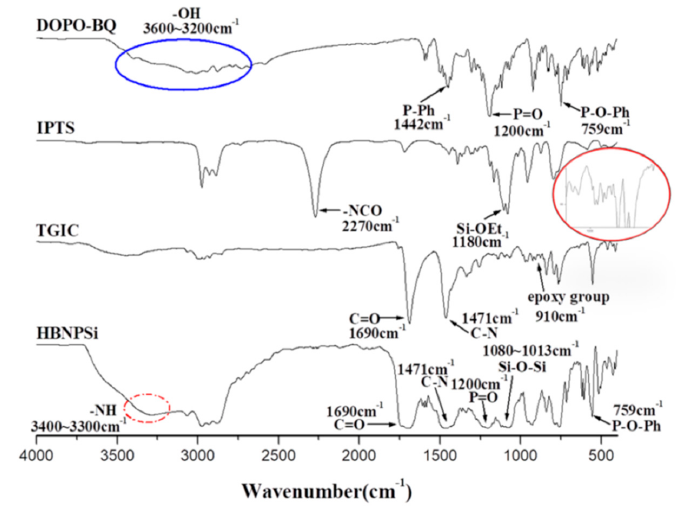
Figure 1. FTIR spectra of DOPO-BQ, IPTS, TGIC, and HBNPSi.